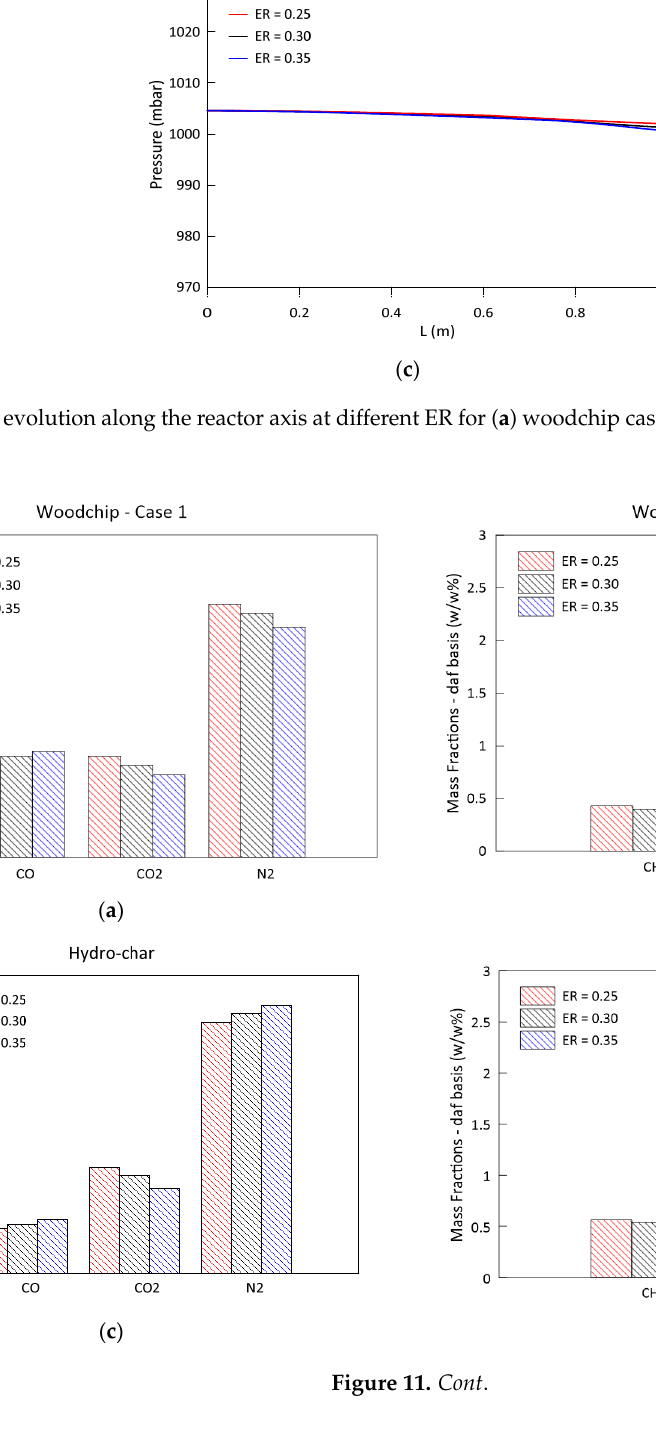
Figure 11. Species mass fractions (on a daf basis) at the reactor exit section, at different ER, for ( a , b ) woodchip case 1, ( c , d ) hydro-char from green waste, ( e , f ) olive pomace gasification.